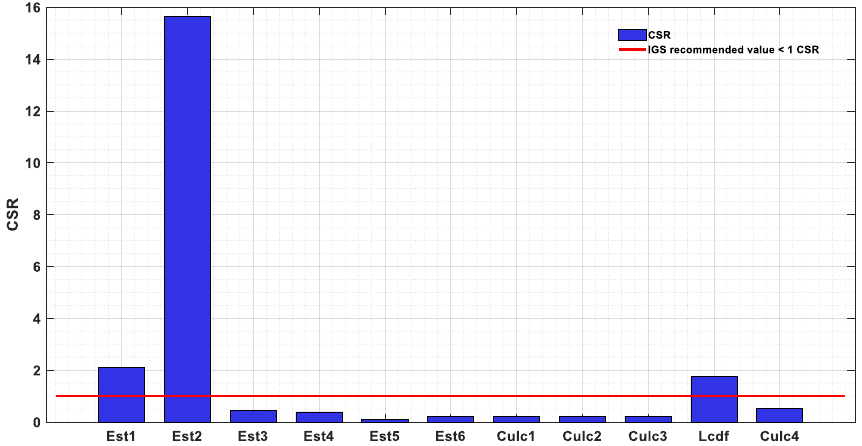
Appl. Sci. 2021 , 11 , x FOR PEER REVIEW Figure 8. Cycle slips per 1000 observations. Red line: 1000/(o/slips) < 1 CSR [36].